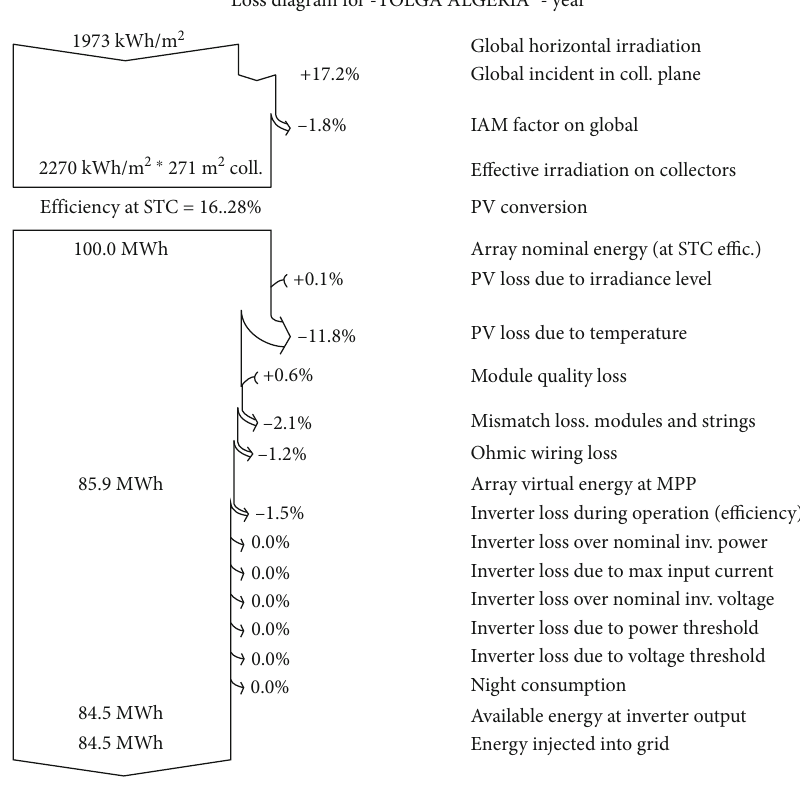
Figure 4: Yearly loss diagram for the PV system of the SE